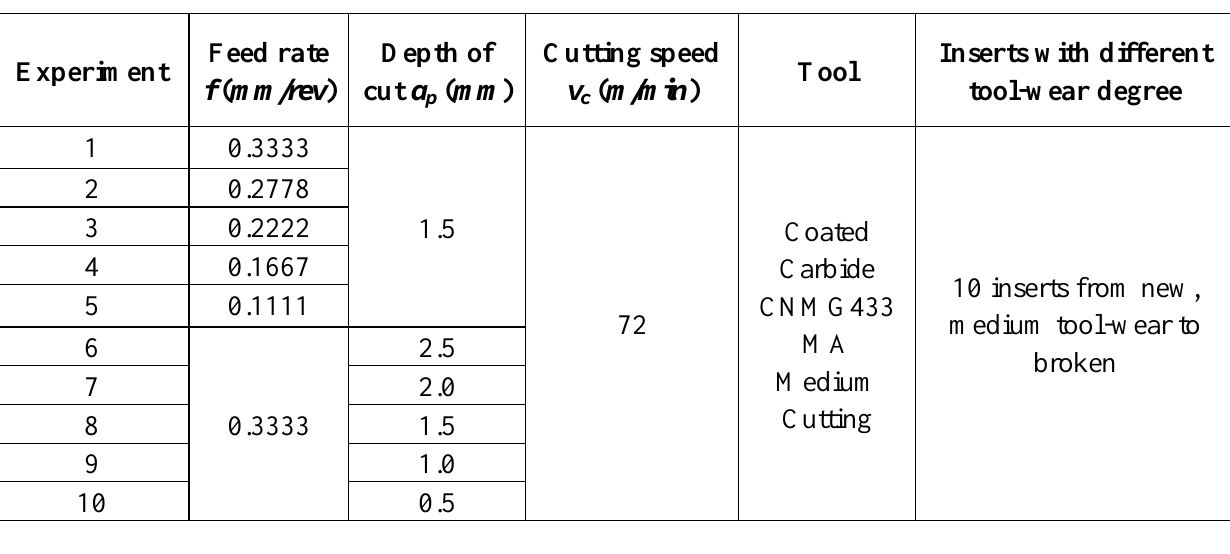
Table 1. Cutting conditions for